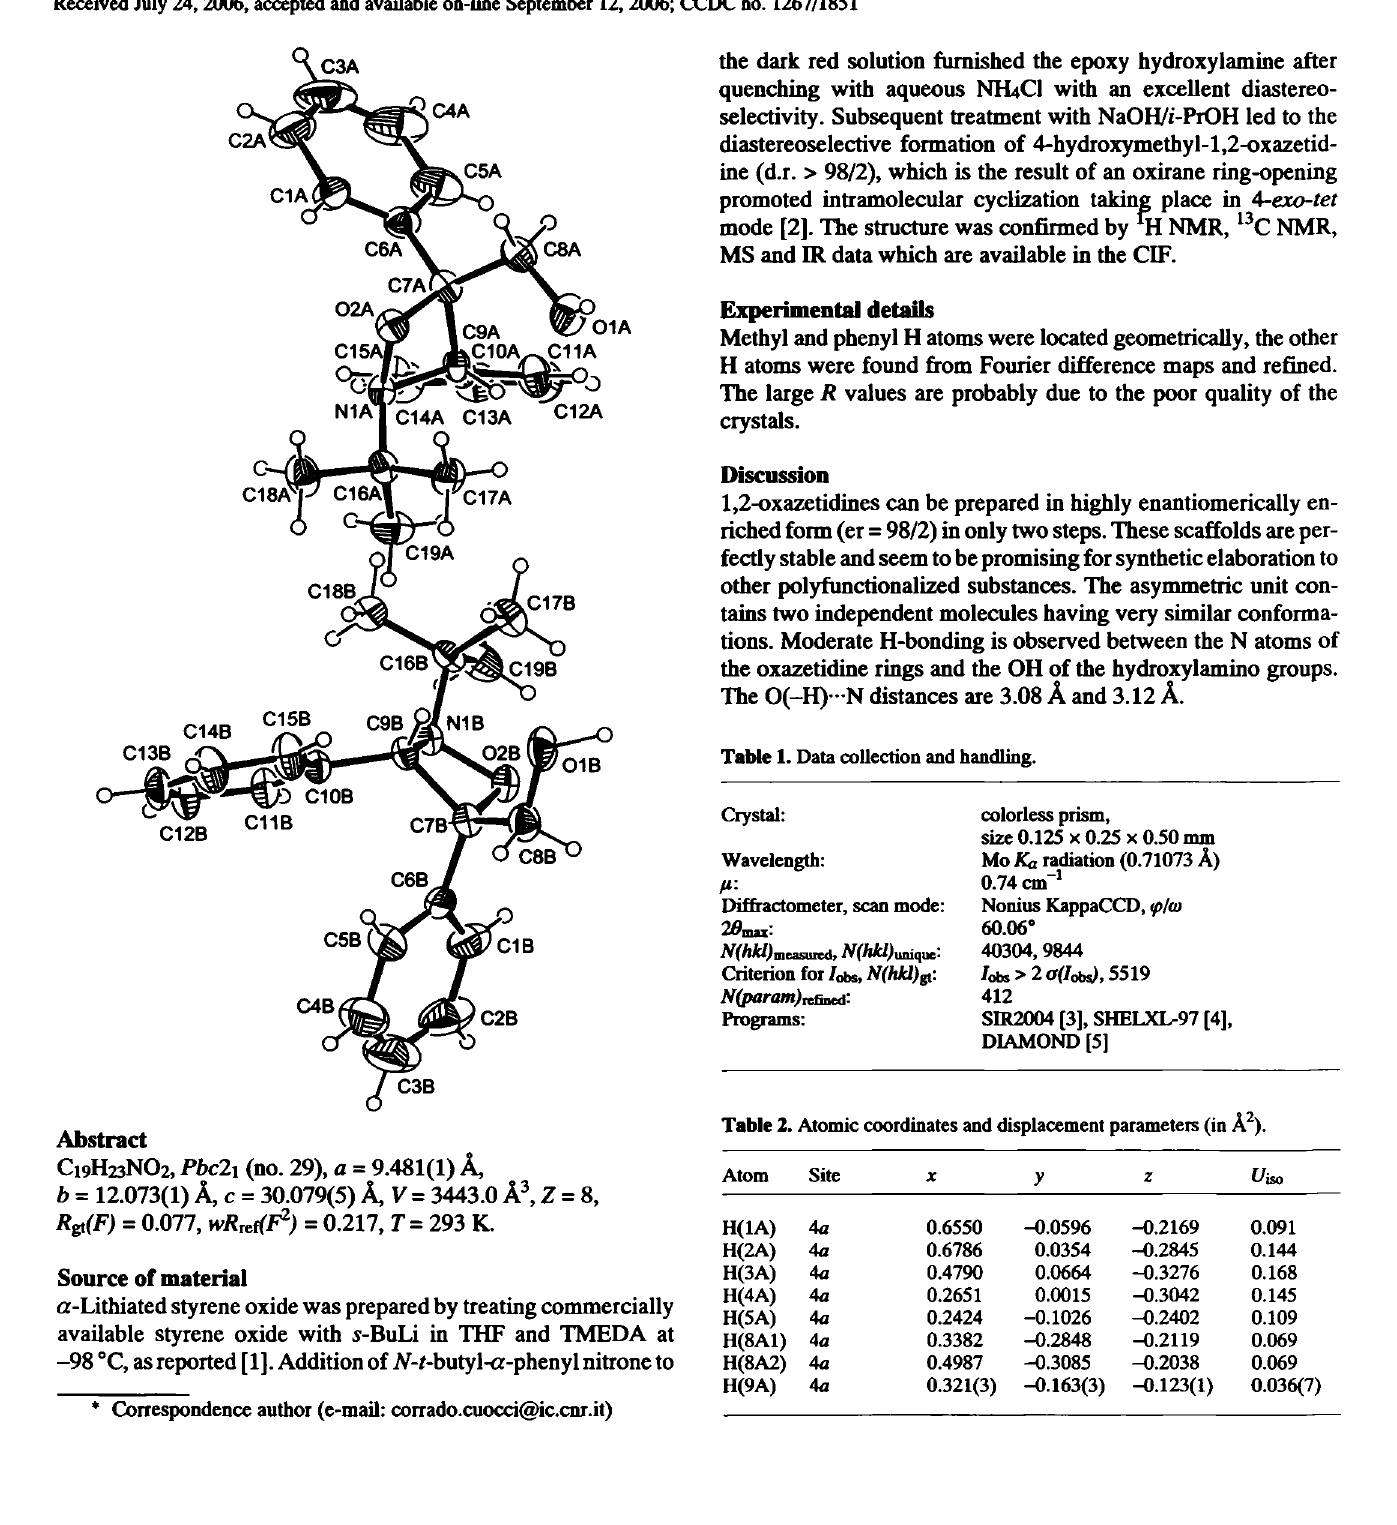
Table 2. Atomic coordinates and displacement parameters (in Ä 2